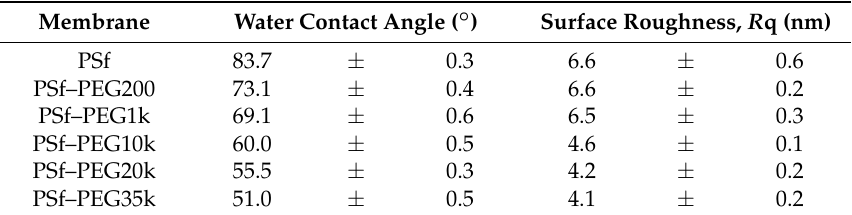
Table 3. Water contact angle and surface roughness of PSf supports prepared using PEG of varying molecular weights.